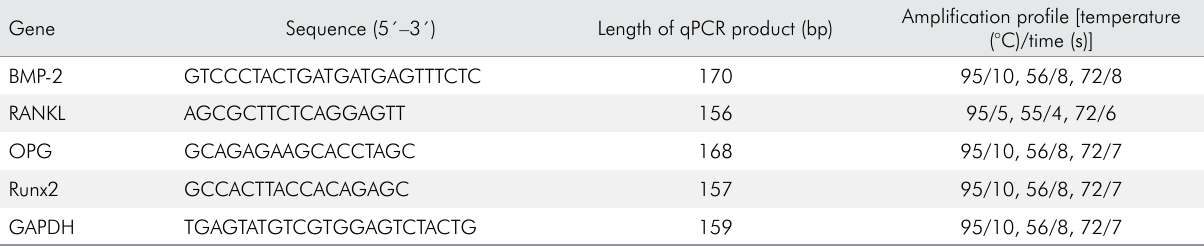
Table. Primer sequences for each gene, amplification profiles, and the estimated length of qPCR product for each gene.